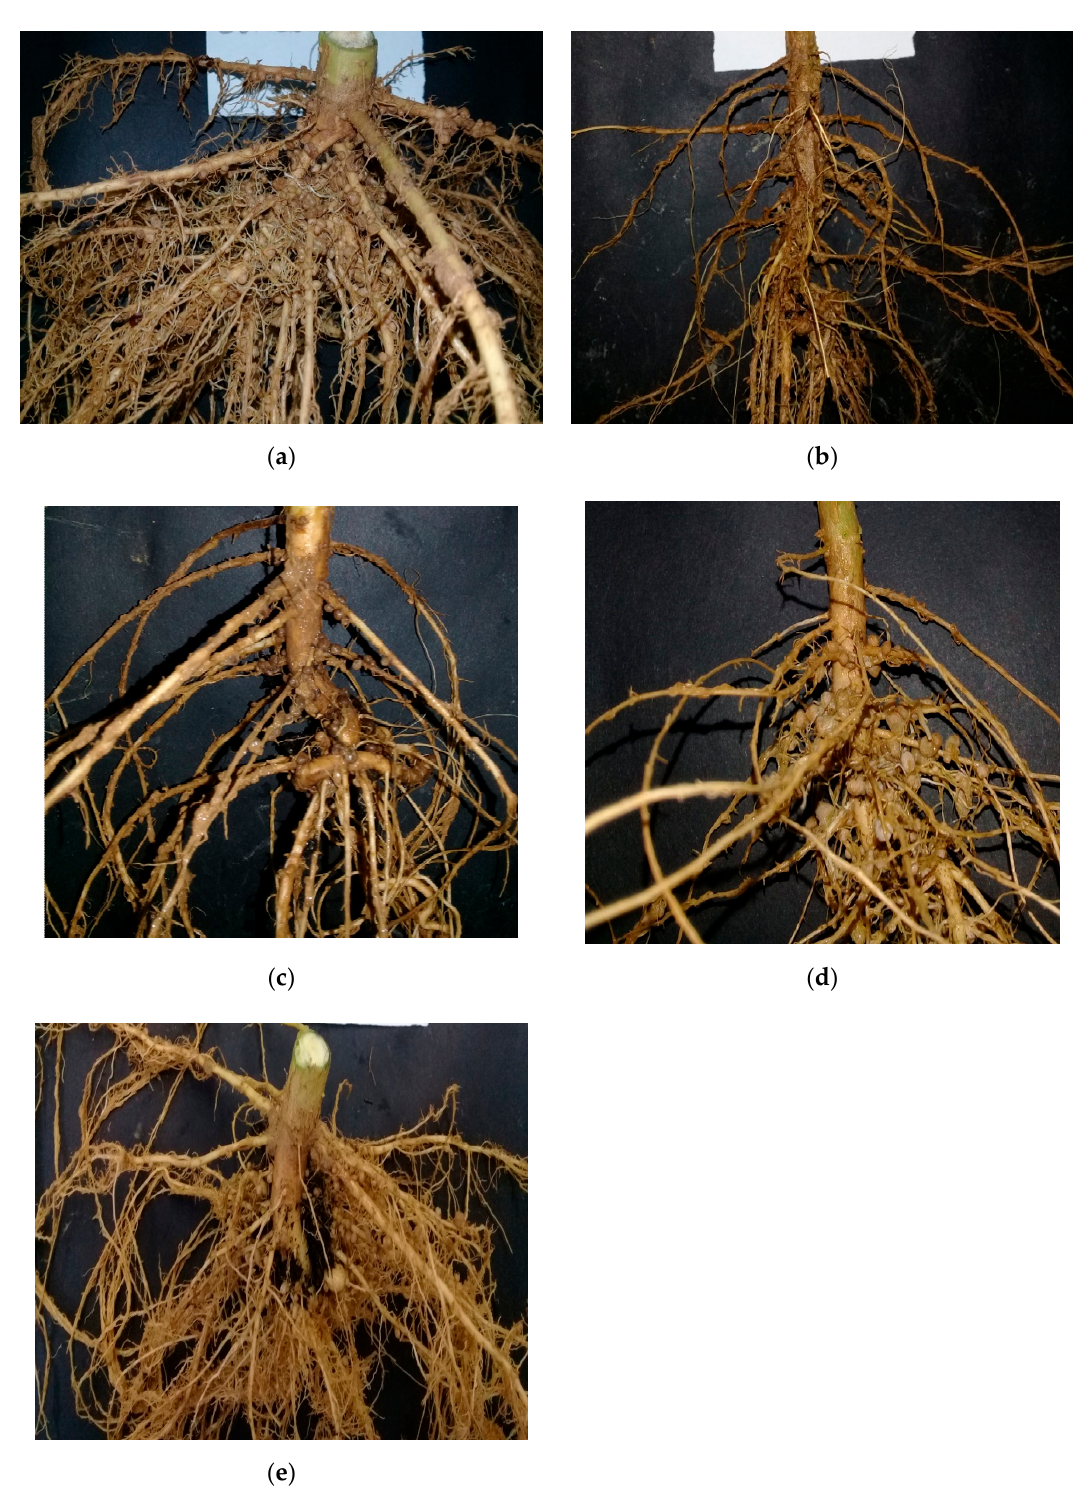
Figure 4. E ff ect of TTE on the roots of Sesbania bispinosa . ( a ) Well water (W); ( b ) Biological Treatment (BT); ( c ) Ultra fi ltration (UF); ( d ) Nano fi ltration (NF); and ( e ): Reverse Osmosis (RO). (BT); ( c ) Ultrafiltration (UF); ( d ) Nanofiltration (NF); and ( e ): Reverse Osmosis